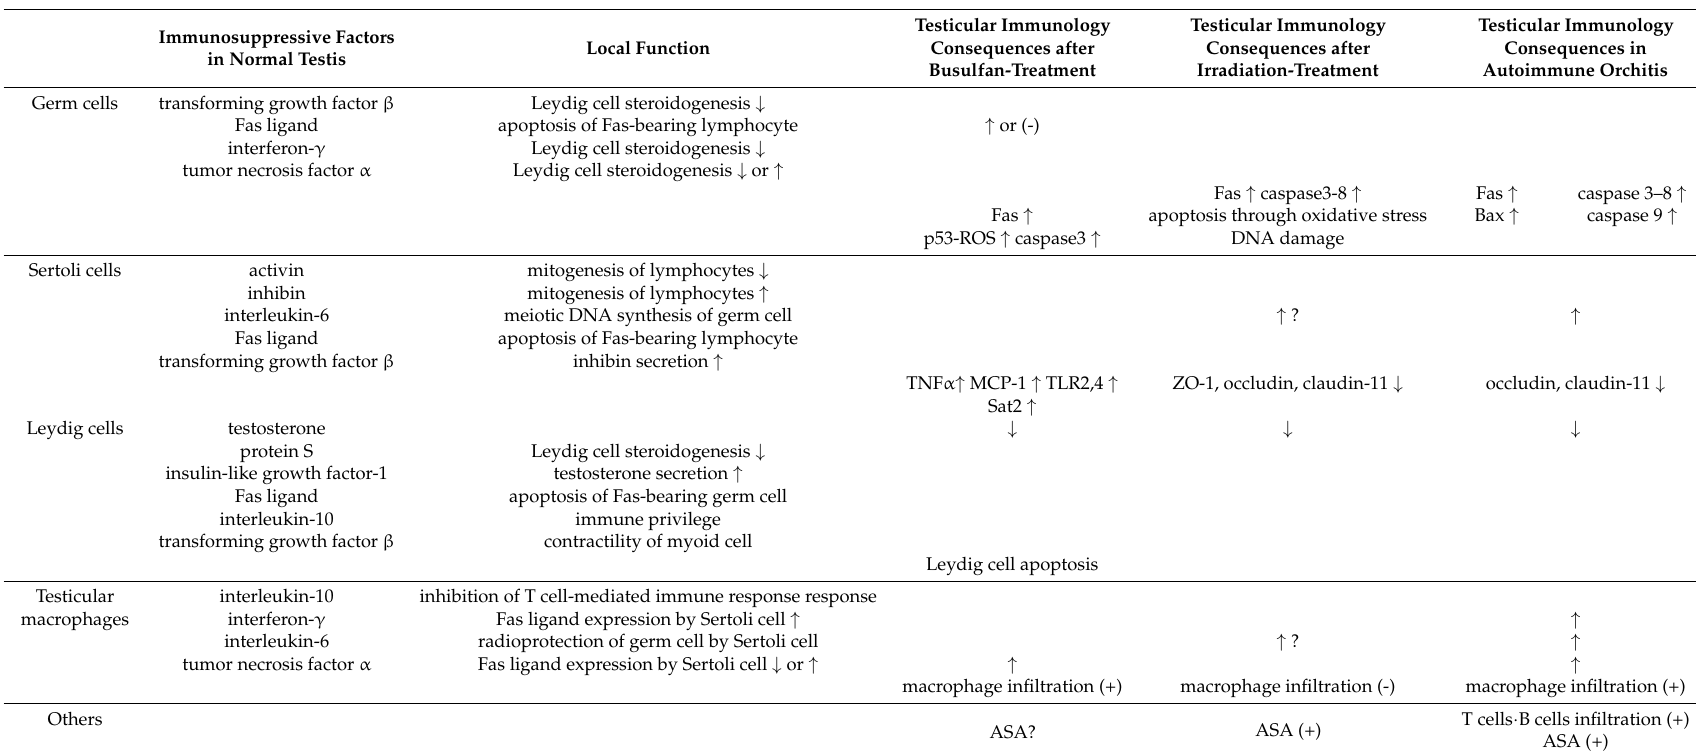
Table 1. Testicular immune factors in normal and cancer-treated